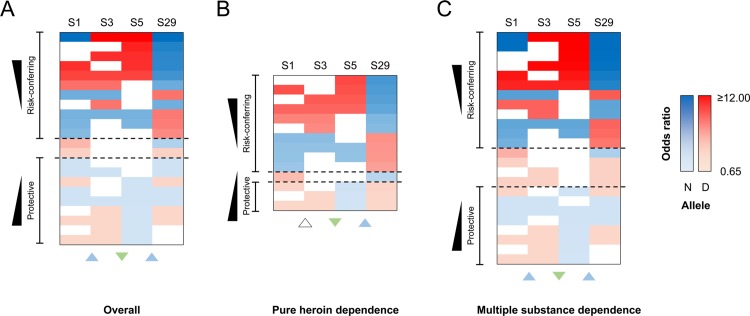
Odds ratio in multiple SNP-containing haplotypes in association with heroin dependence.Individual 2-, 3-, and 4-SNPs haplotypes, containing S1, S3, S5, and S29, significantly associated with heroin dependence (P < 0.05; PGlobal < 0.05) are organized by their odds ratio (OR) in a descending order. Odd ratio of 1.00 serves as the baseline for determining haplotype risks. A blue square block represents the ancestral allele and a red square block represents the derived allele. An upward arrowhead in blue color shows risk-conferring effect of recombination and a downward arrowhead in green color shows protective effect of recombination. Neutral effect of recombination is represented by an upward arrowhead in white color. Dashed lines represent the cutoffs. Refer to S8 Table for further information on this figure. (A) Odds ratio of haplotypes in comparing overall heroin dependent (HER) and combined control (CON) groups (case n = 564; control n = 498). Odds ratio ≥ 4.73 is chosen as a cutoff for risk-conferring haplotypes to heroin dependence. Odds ratio ≤ 0.81 is chosen as a cutoff for protective haplotypes from heroin dependence. (B) Odds ratio of haplotypes in comparing pure heroin dependent subgroup and CON group (case n = 318; control n = 498). Odds ratio ≥ 3.55 is chosen as a cutoff for risk-conferring haplotypes to heroin dependence and OR ≤ 0.79 is chosen as a cutoff for protective haplotypes from heroin dependence. (C) Odds ratio of haplotypes in comparing multiple substance dependent subgroup and CON group (case n = 246; control n = 498). Odds ratio ≥ 5.72 is chosen as a cutoff for risk-conferring haplotypes to heroin dependence. Odds ratio ≤ 0.78 is chosen as a cutoff for protective haplotypes from heroin dependence.